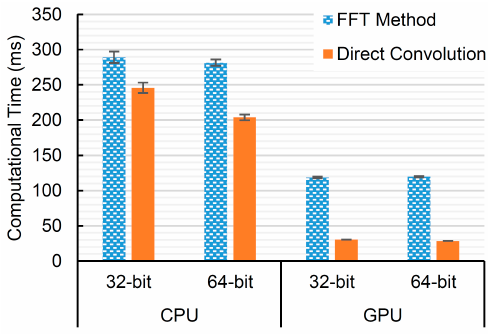
Figure 4. The computational times of applying an 11-point high-pass filter on 2592 signals (from 32 Rx elements × 81 scanlines) of 8192 samples using the Fourier transform method and direct convolution. These methods are executed on different computer platforms of 32 and 64 bits and using the CPU and the GPU. The error bars are one standard deviation over 100